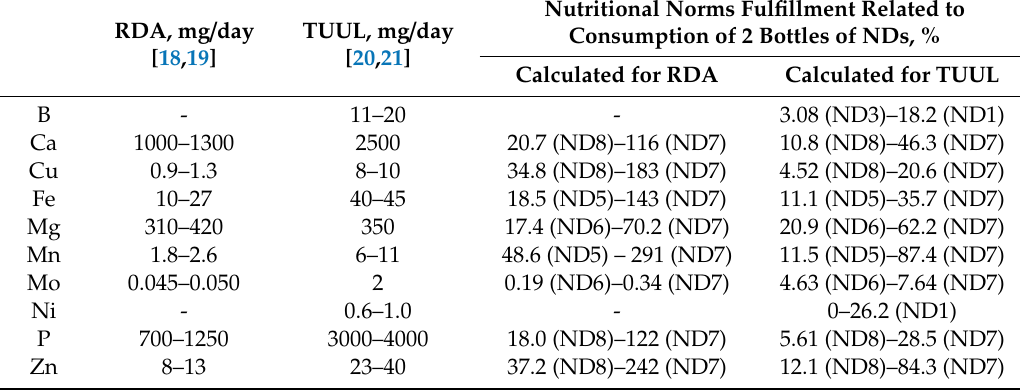
Table 4. The assessed nutritive value of nutritional drinks (NDs) compared to recommended daily dose